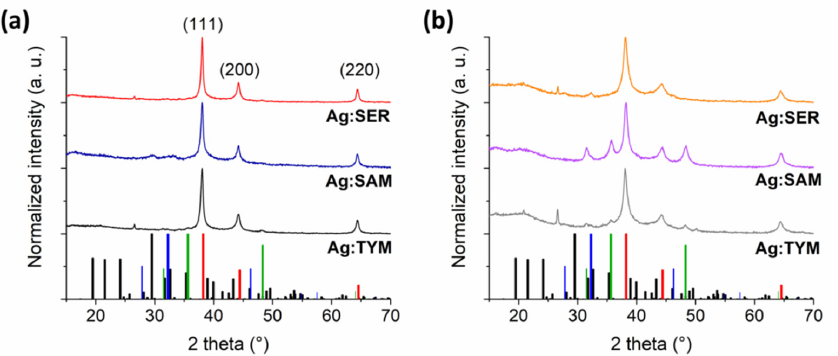
Figure 2. XRD patterns of washed Ag:plant samples; ( a ) 1:1 (three main diffractions of the formed face-centered cubic Ag 0 are indexed), and ( b ) 1:10 (bars at the bottom refer to XRD of ICDD database: AgNO3 (black, 074-2076), Ag (red, 65-2871), WC (green, 51-0939) and AgCl (blue, 71-5209)).